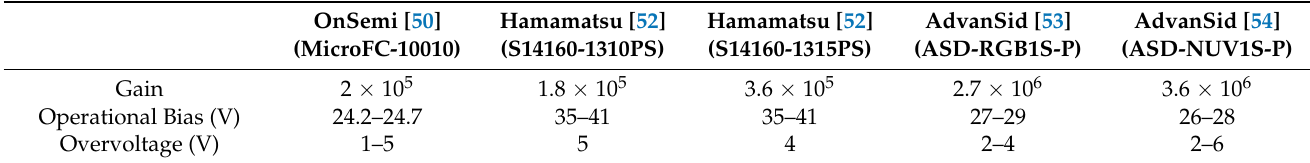
Table 2. Comparison of different SiPM